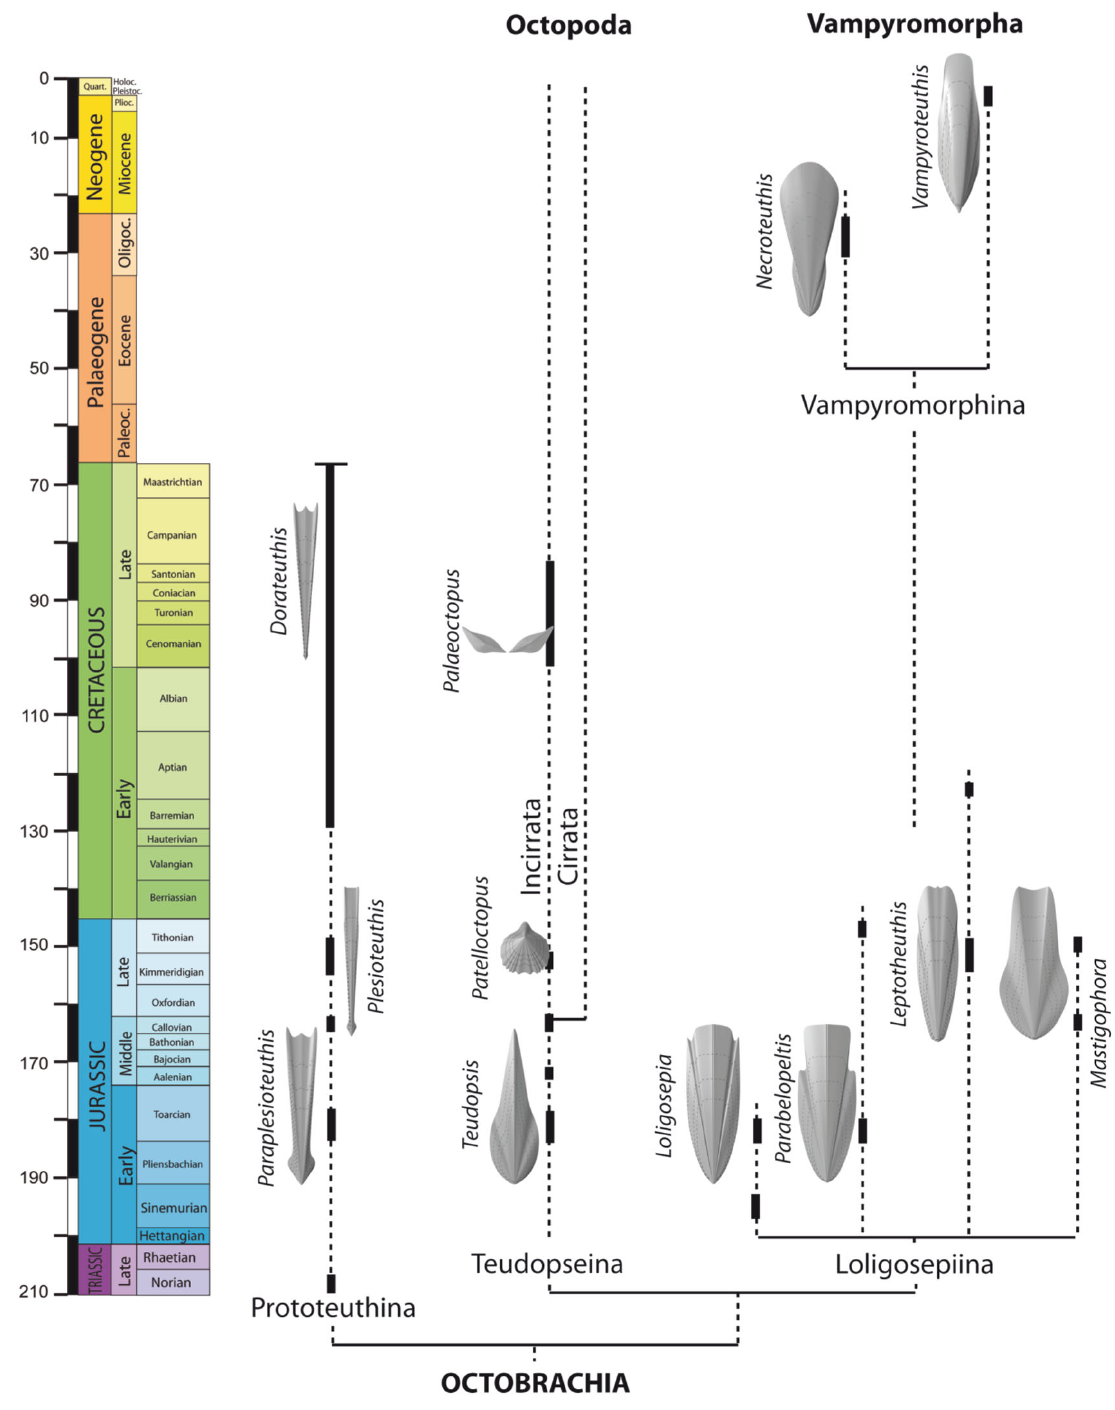
Fig. 6 Phylogeny and stratigraphic distribution of the Octobrachia. The presumed relationship between loligosepiid suborders Vampyromorphina and Loligosepiina is indicated. Note, not all genera within Loligosepiina are fi gured (after 26 , this